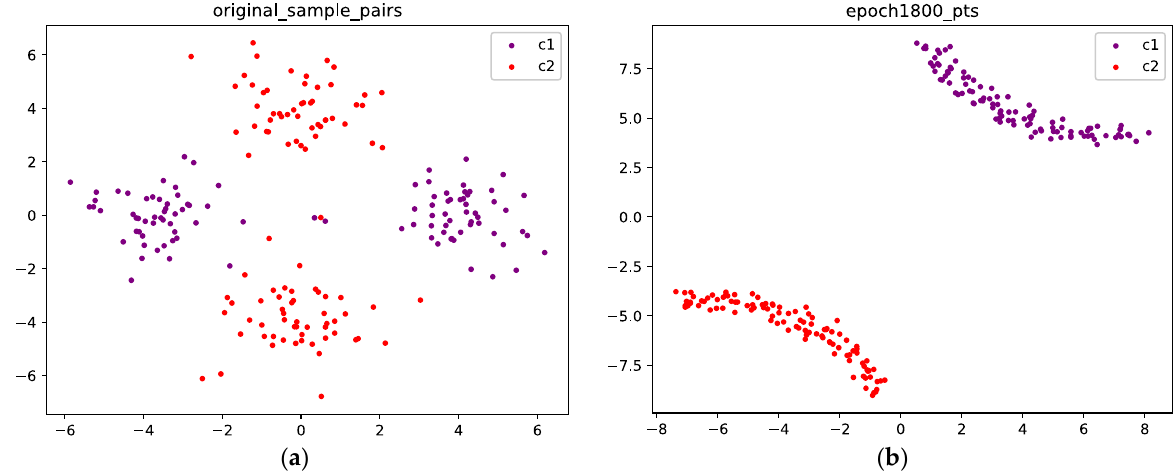
Figure 8. ( a ) The original points are sampled from a Gaussian mixture with four components, and each class corresponds to two components; the purple points are sampled from class 1, and the red points are sampled from class 2; ( b ) Optimized configuration after 1800 epochs; the points from the two classes are well separated.